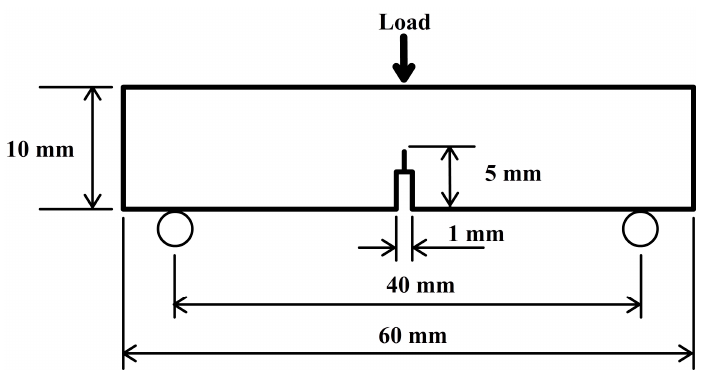
Figure 1. Single-edge notch three-point bending (SEN-3PB) specimen geometry used for the fracture toughness.